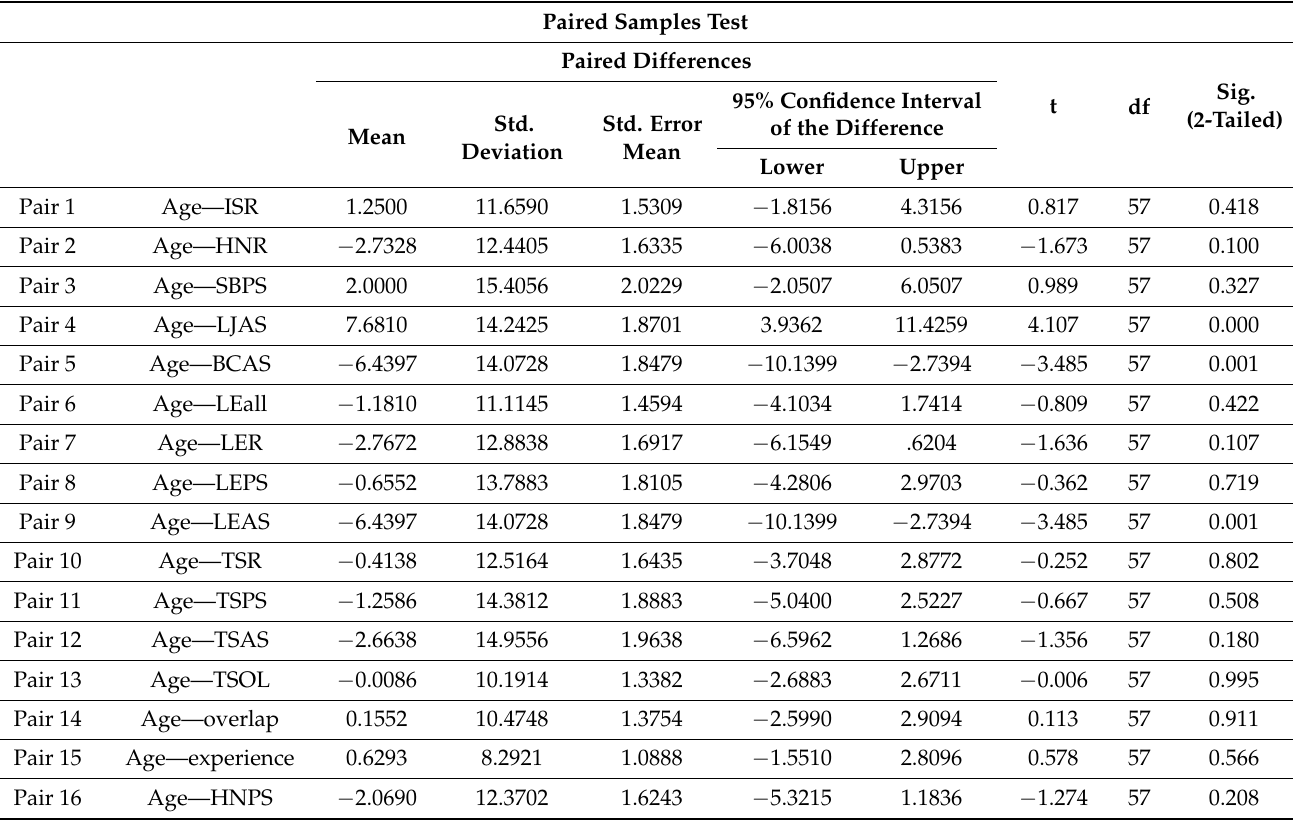
Table 4. Paired Sample t -test comparing actual and estimated age. Significant values are bolded.